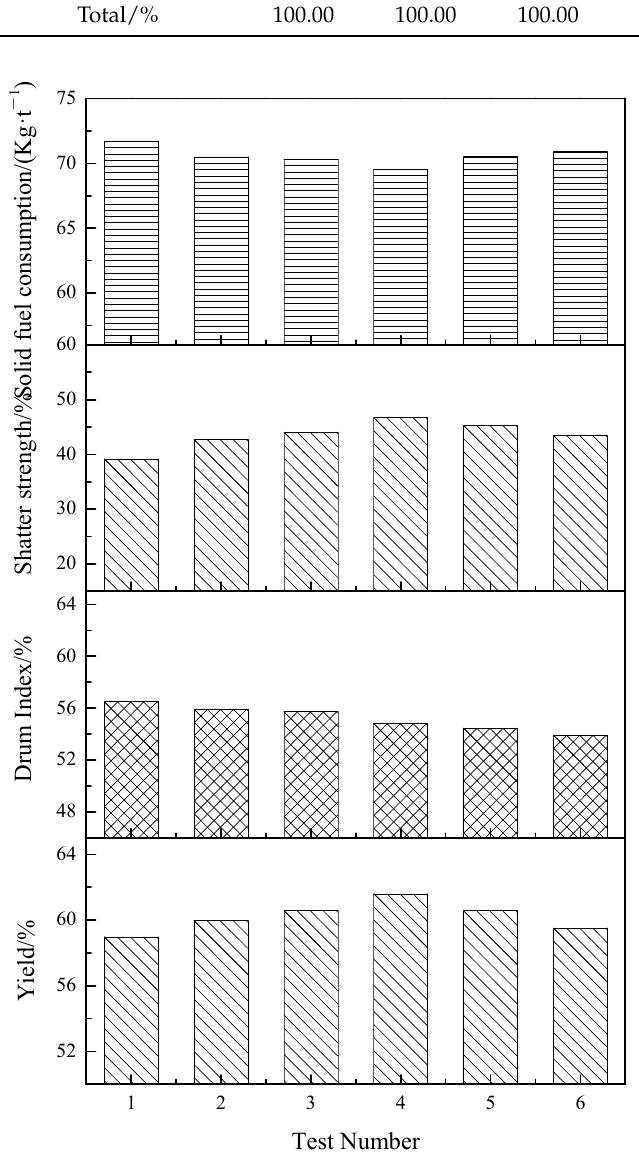
Figure 6. Sintering indexes at different ignition time intervals and layer height proportions.